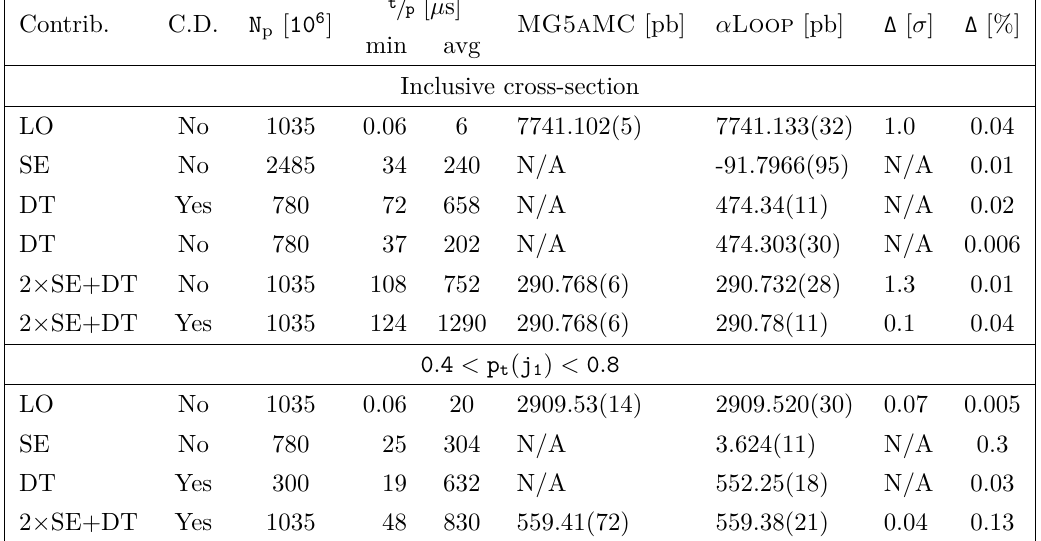
Table 1. Numerical results for the NLOQCD accurate (semi-)inclusive cross-section for the process ¯ e + e − → γ ? → d d . The second column entitled “C.D.” stands for “Contour